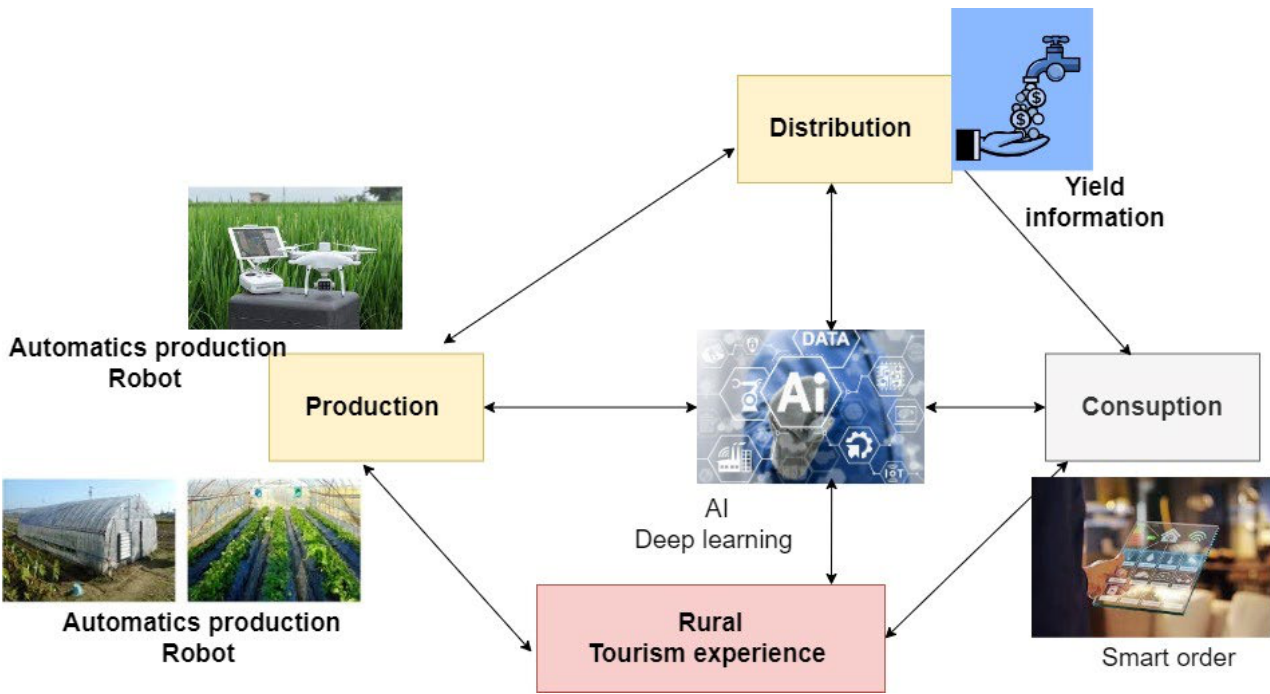
Figure 2. Artificial intelligence based on IoT for improving the agriculture sector.